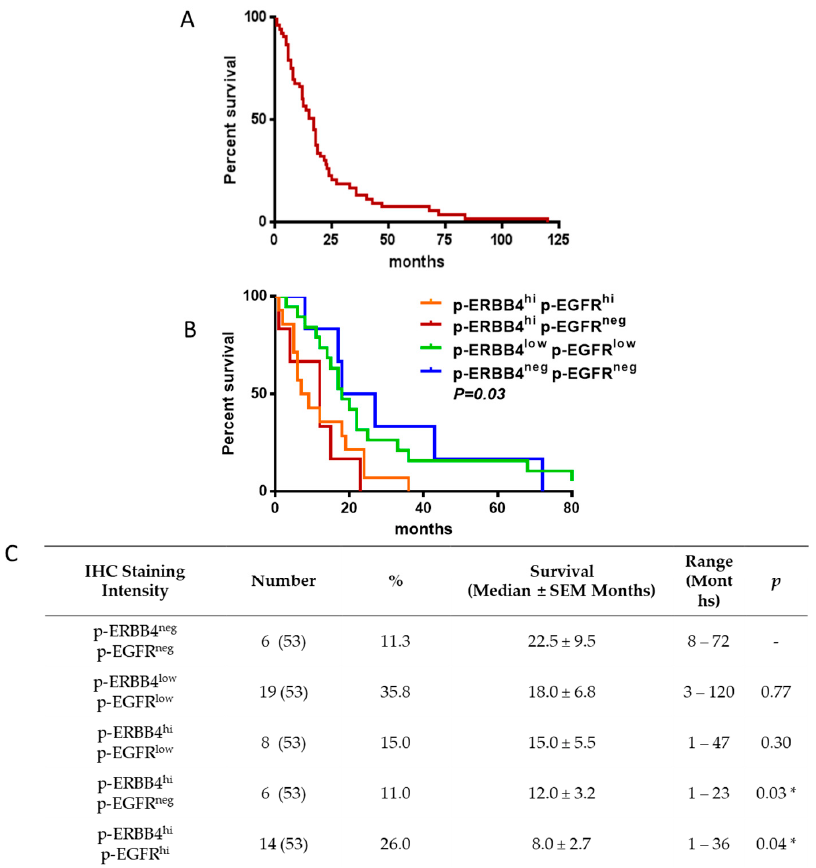
Figure 4. Comparative survival of patients with GBM. The overall survival for the 53 patients with GBM for whom survival data were available ranged from 1 to 120 months ( A ). Graphical ( B ) and tabulated ( C ) survival outcomes associated with patient samples with high (hi), low (low) and no (neg) p-ERBB4 or p-EGFR staining by IHC. Combinations not shown in the table were not identified.